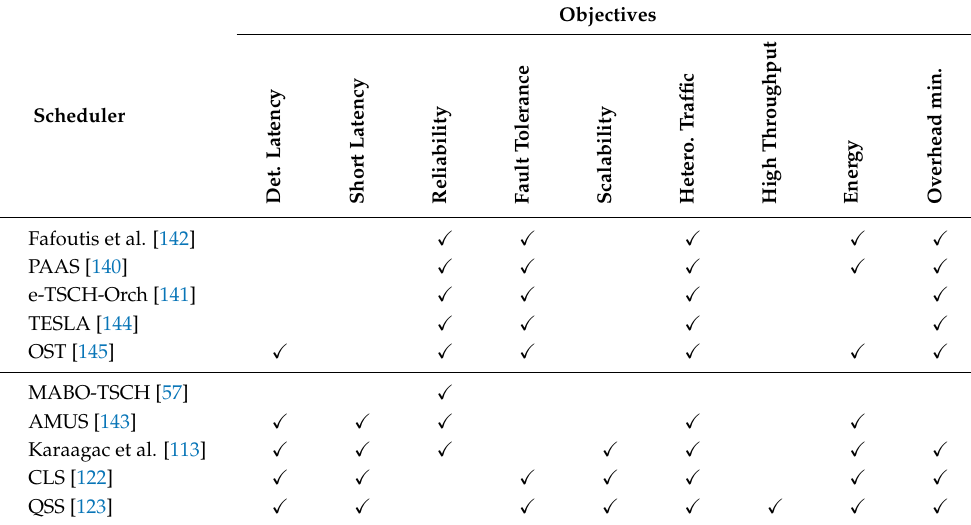
Table 12. Evaluation of hybrid